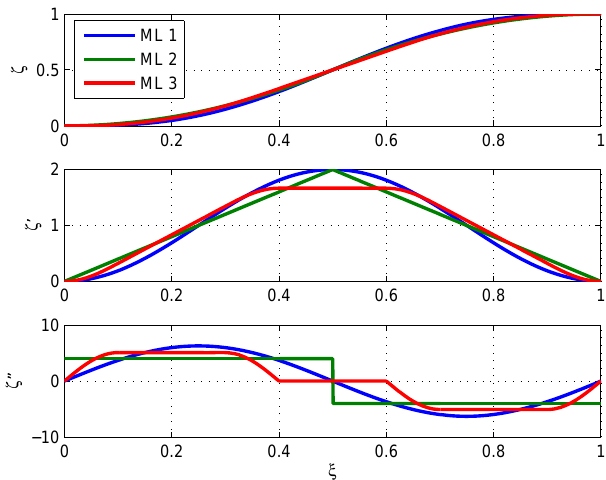
Figure 6. Comparison between different motion laws.